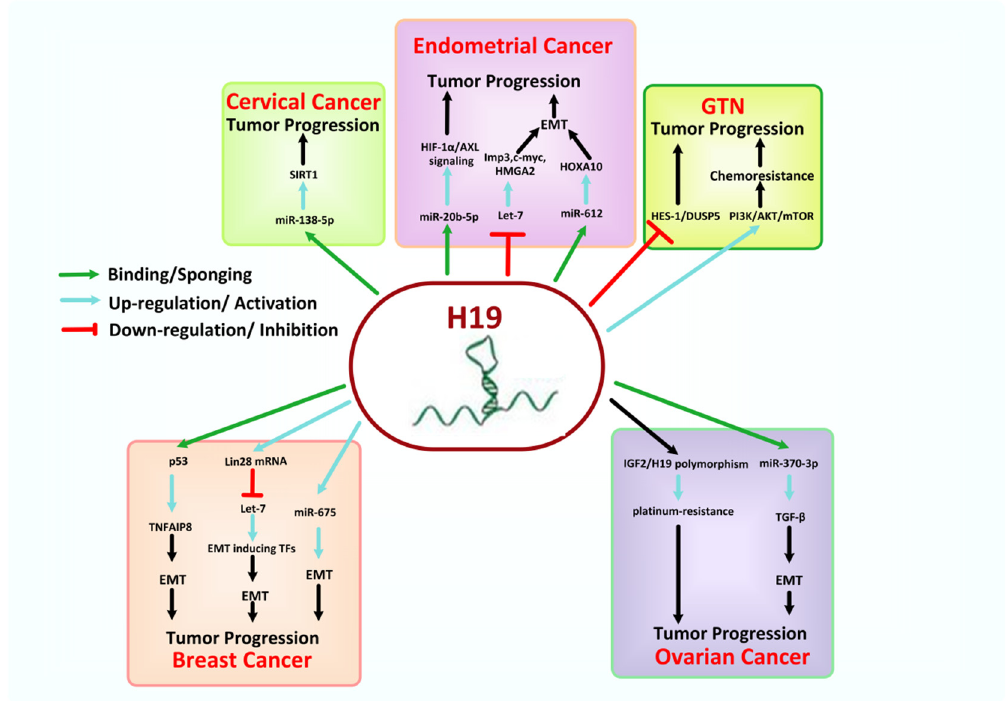
Figure 6. Mechanism associated with the oncogenic role of H19 in female-oriented cancers.